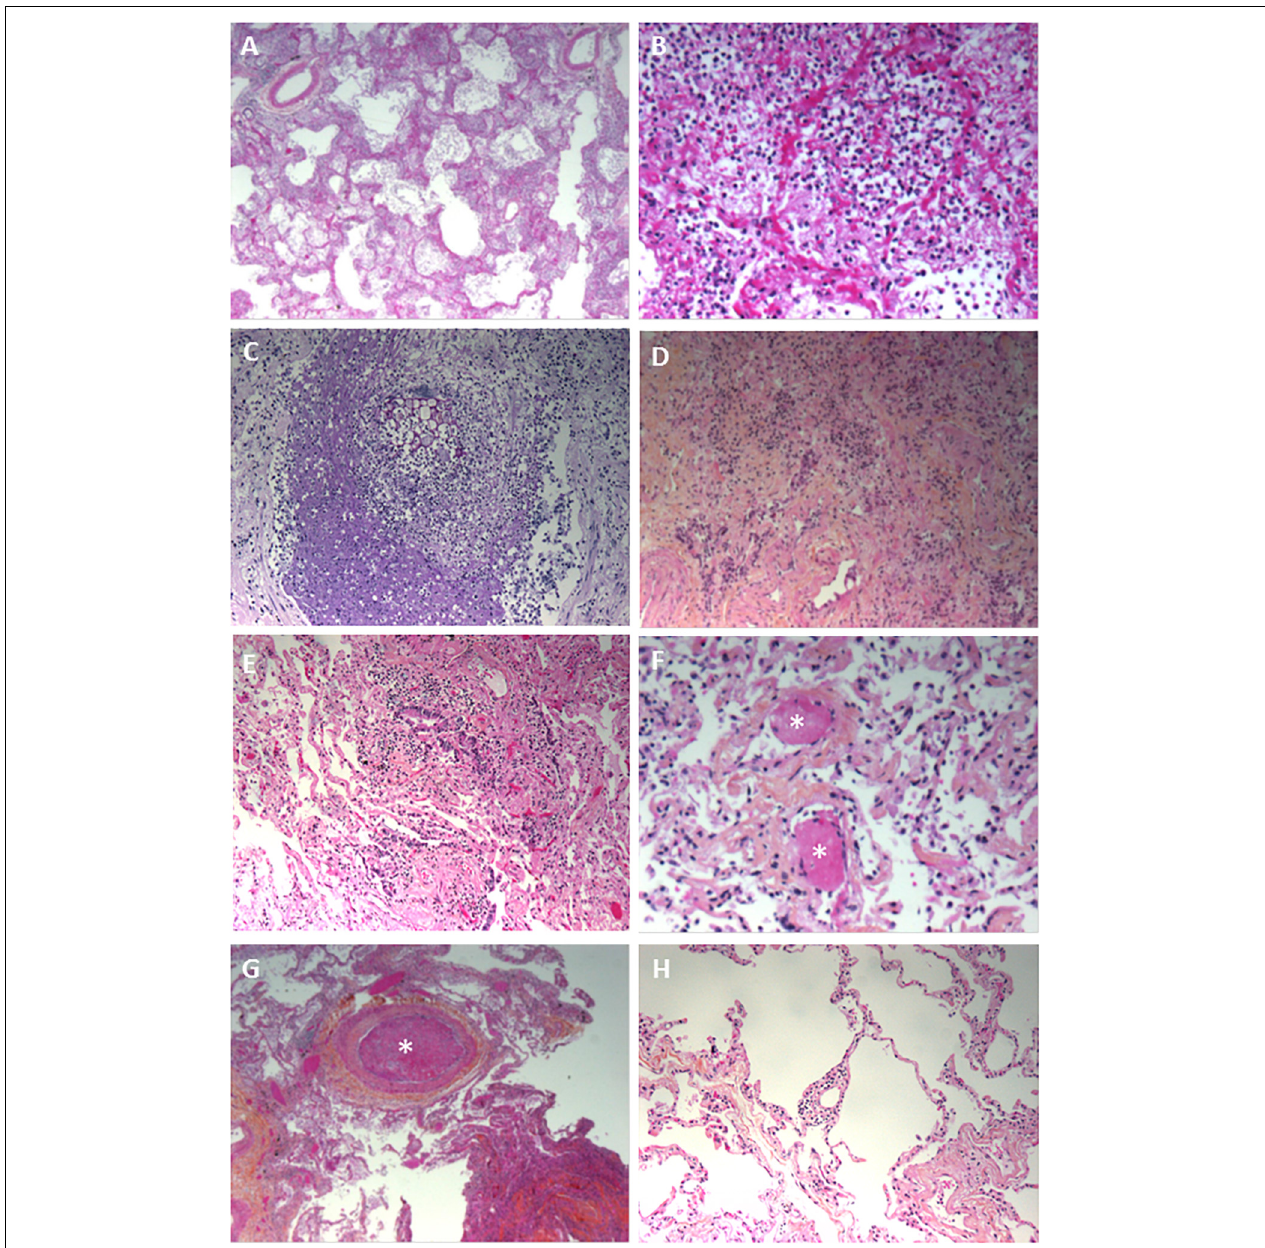
FIGURE 1 | Pathology findings for the lungs in deceased patients with COVID-19. (A) Fibrinous alveolitis; hematoxylin-eosin-saffron × 100. (B) Suppurative alveolitis with alveoli full of neutrophils and fibrin; hematoxylin-eosin-saffron, × 400. (C) Collapsed alveoli with thickened fibrous septa and an inflammatory infiltrate (lymphocytes and macrophages); hematoxylin-eosin-saffron, × 100. (D) Aspiration pneumonia with a foreign body and neutrophils in the lumen of a bronchiole; hematoxylin-eosin-saffron, × 400. (E) Bronchiolitis, lymphocytic infiltrate surrounding a bronchiole; hematoxylin-eosin-saffron, × 100. (F) Microthrombi in lung capillaries; hematoxylin-eosin-saffron, × 400. (G) Pulmonary embolism with a fibrinous thrombi in the lumen of a pulmonary artery; hematoxylin-eosin-saffron, × 100. (H) Lymphocytic vasculitis, with lymphocytic infiltrate surrounding a small pulmonary vessel; hematoxylin-eosin-saffron, × 100.